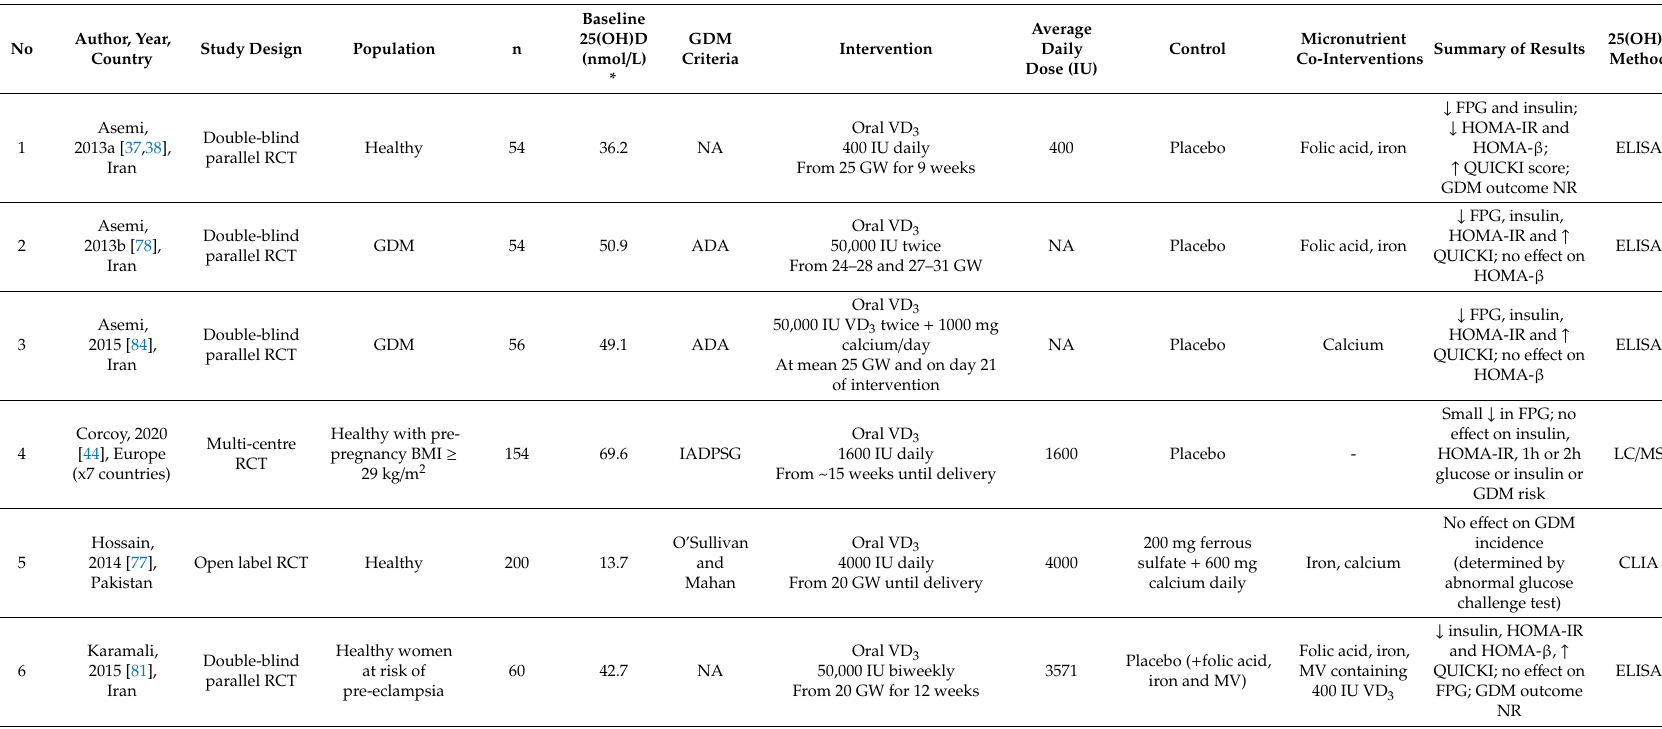
Table 1. Characteristics of randomised controlled trials examining the e ffi cacy of vitamin D supplementation on reducing incident GDM or improving maternal glycaemic